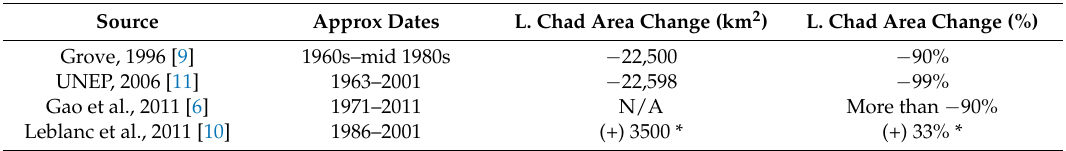
Table 1. Descriptions of Lake Chad area changes for extended periods found in the